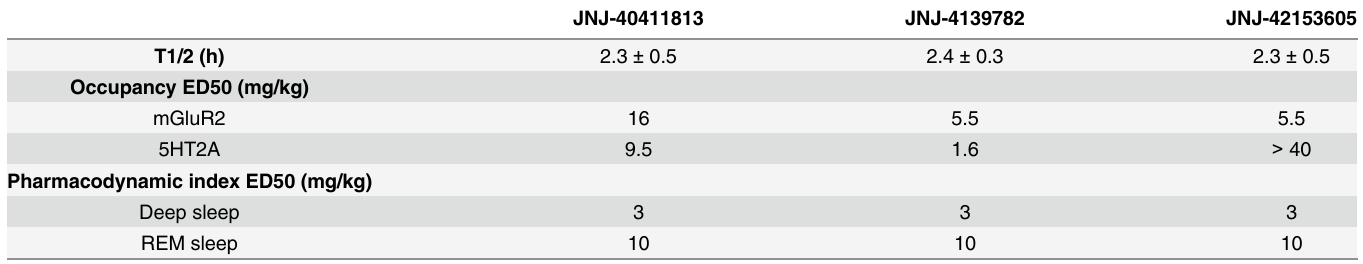
Table 1. Summary of halve-lives (T 1/2 expressed in h), brain receptor occupancy (Efficacy Dose “ ED 50 ” expressed in mg/kg) and pharmacodynam- ics effect of published mGluR2 PAMs (JNJ-40411813, JNJ-40068782, JNJ-42153605) on sleep measures in rats (Lowest Active Dose “ LAD ” expressed in mg/kg)